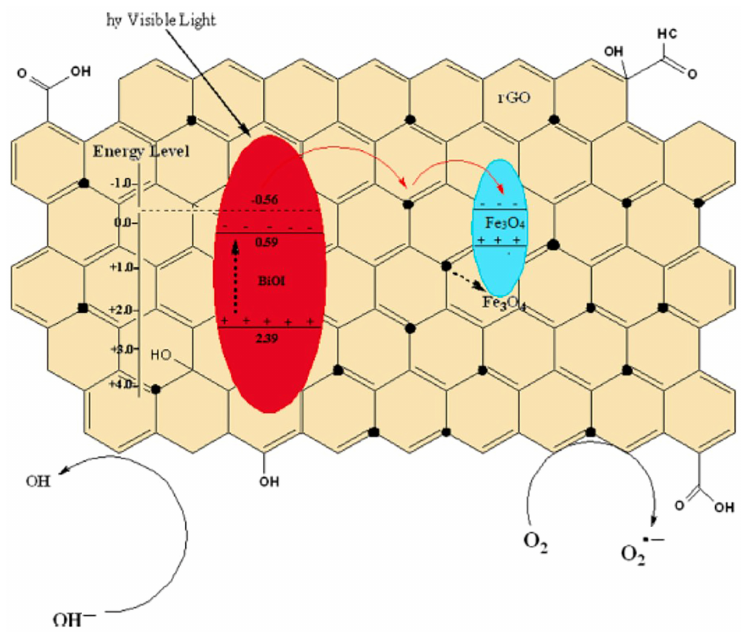
Figure 3. Function of Fe 3 O 4 NPs in the catalytic oxidation of pollutants [75], Copyright 2022 Elsevier.